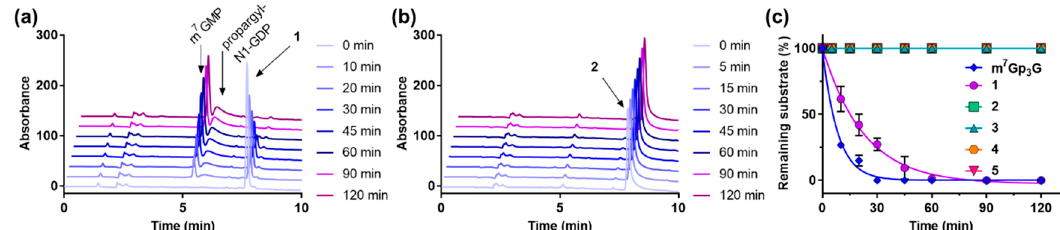
Figure 3. Enzymatic degradation of cap analogs 1 – 5 (30 µM) by human decapping scavenger enzyme (hDcpS) (30 nM) monitored by RP-HPLC. Representative time-dependent RP-HPLC profiles for compounds 1 ( a ) and 2 ( b ). Percentage of residual substrate as a function of time for all compounds ( c ). Data are average of triplicate experiments ± SD.